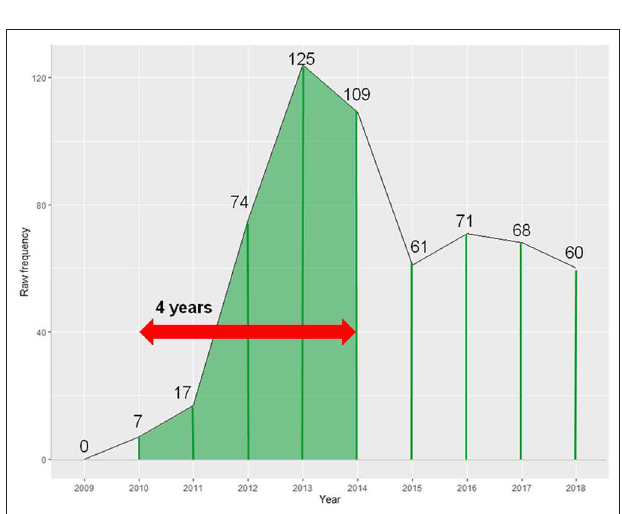
FIGURE 7 | Calculating the half-life of a hashtag.